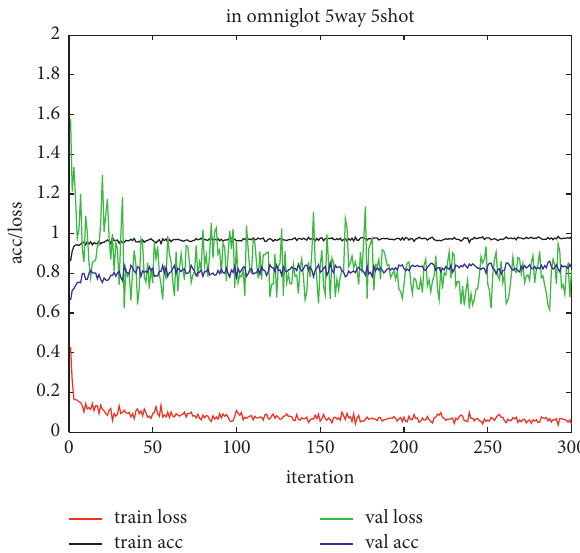
Figure 5: Performance of EW-CACTUs-MAML on Omniglot.